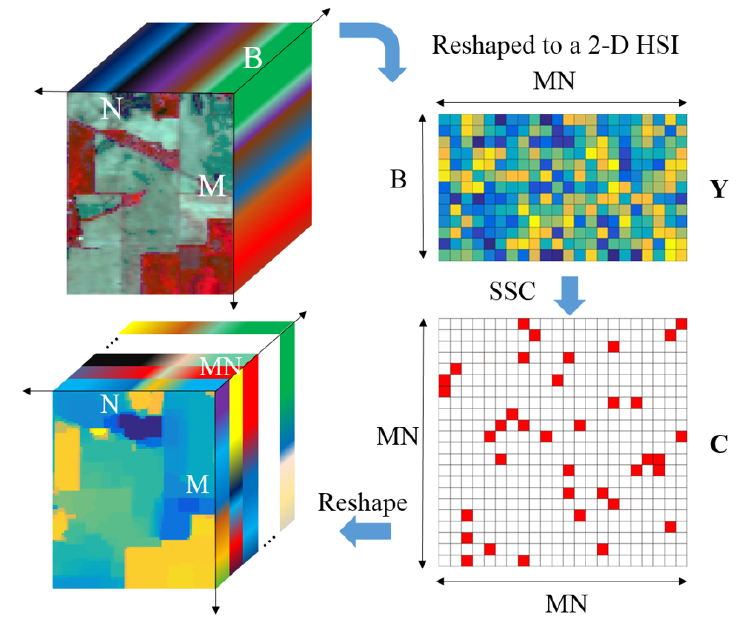
Figure 1. A motivation for applying the TV norm in the sparse subspace clustering (SSC) model. In the ideal case, coefficient matrices of pixels in hyperspectral images (HSIs) should be piece-wise smooth in local region and have similar edges to the original HSI, which becomes apparent after reshaping them to a 3-D cube. Observe that each M × N slice in this cube corresponds to one row in the 2-D matrix C and resembles the spatial structures in the original HSI. In order to preserve such smoothness in local regions and edge structure of the coefficient matrix, the TV spatial constraint is